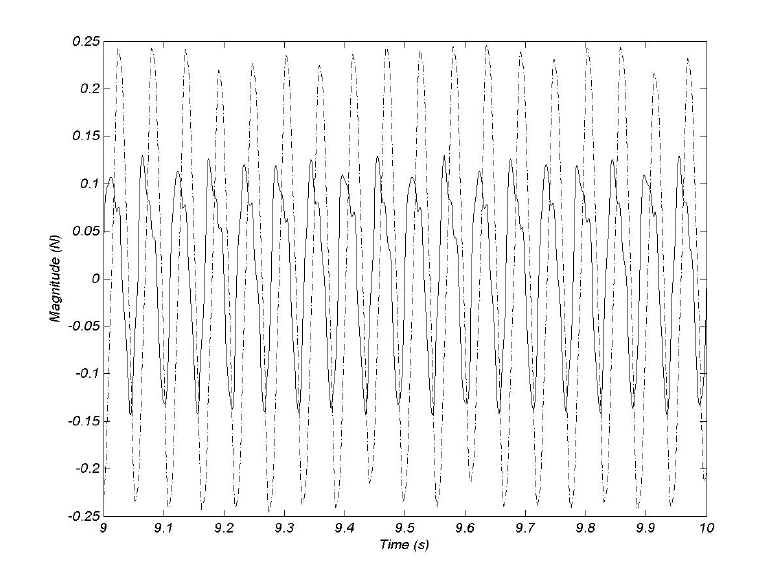
Fig. 30. Transmitted force variations of the system using the both PID and NN controllers subjected to periodic engine disturbance at idling frequency at the final 1 seconds of the simulation. PID controlled (–) and NN controlled